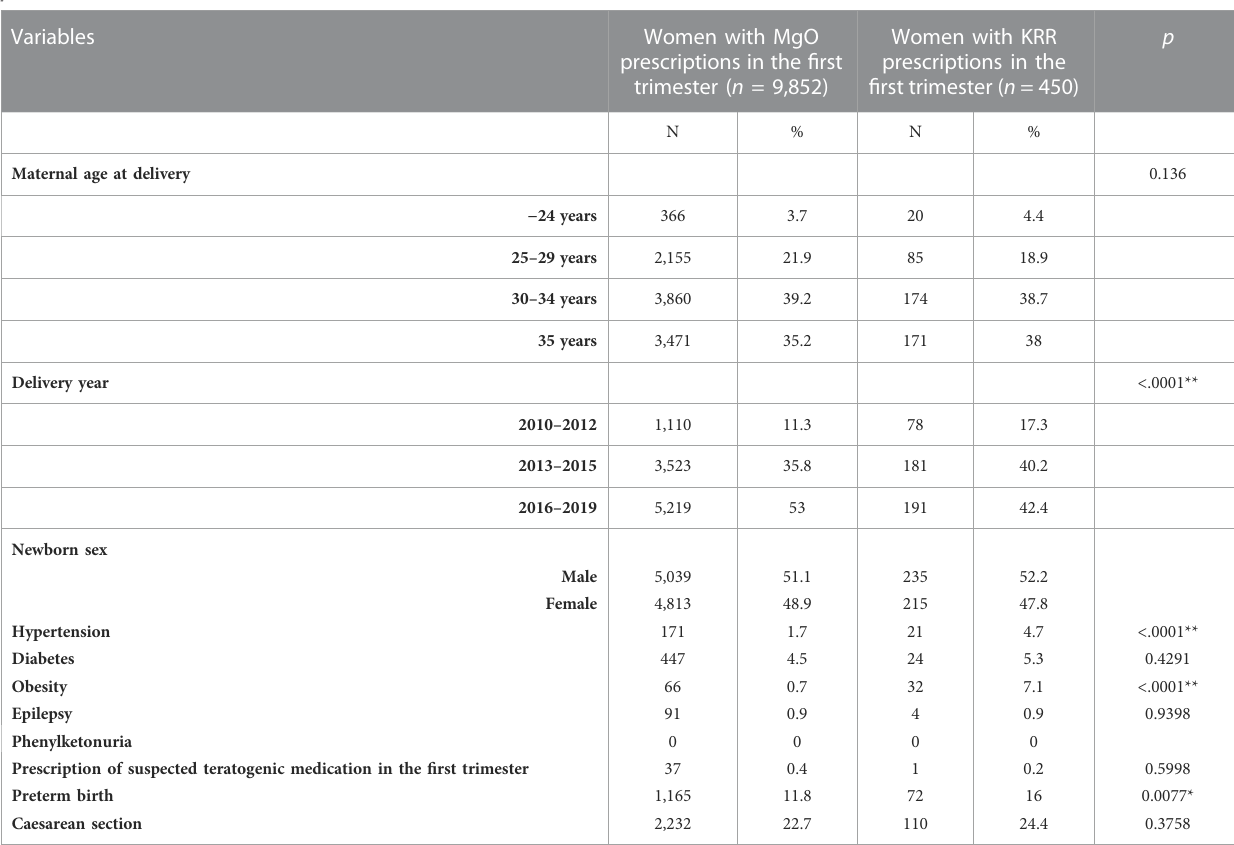
TABLE 1 Study population characteristics during the fi rst trimester of pregnancy. Statistically signi fi cant as p * < 0.05 and statistically highly signi fi cant as p ** < 0.001.